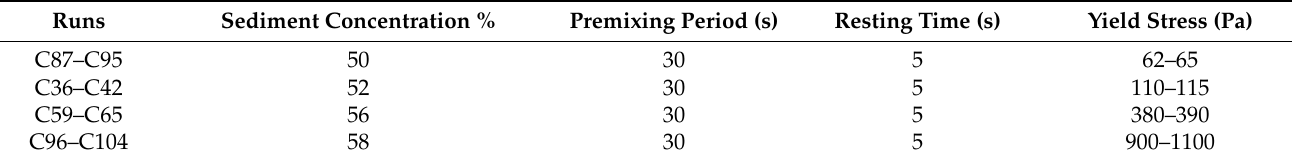
Table 3. Yield stress according to the creep tests.